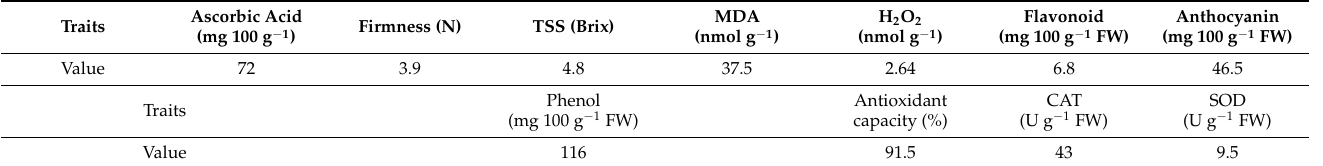
Table 2. Qualitative attributes of the camarosa strawberry cultivar at harvest